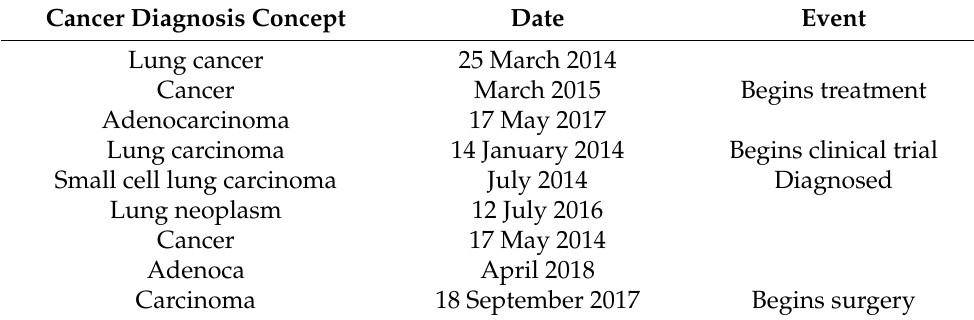
Table 2. A set of extracted